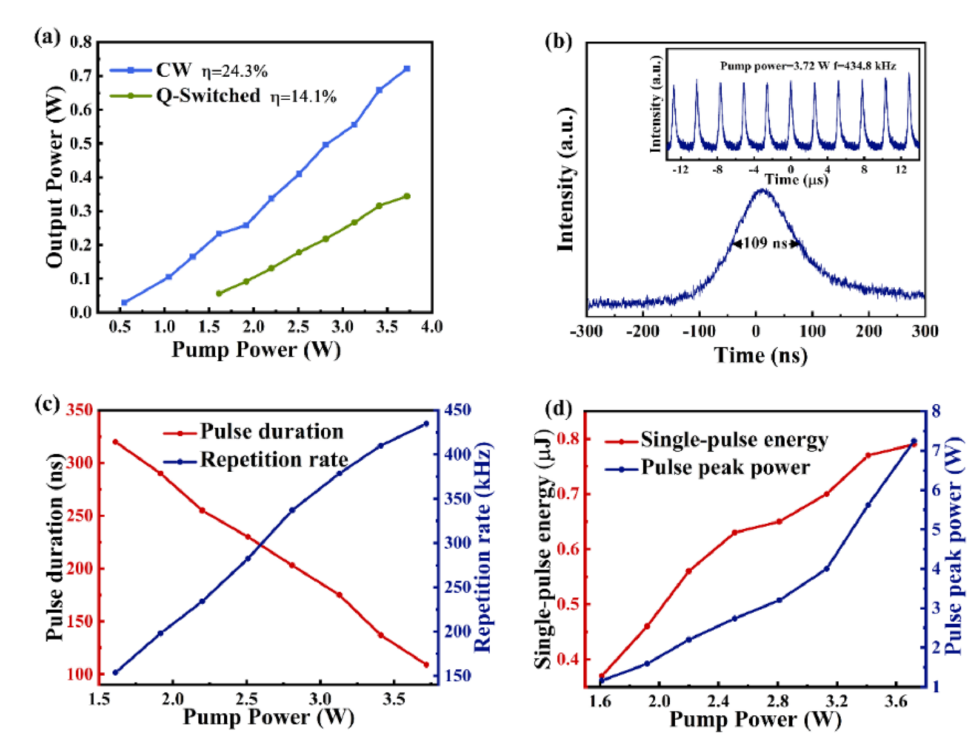
Figure 9. Q-Switched pulse output characteristics with the Ti 2 CT x -GO SA. ( a ) Average output power of continuous wave (CW) and Q-switched lasers under different pump powers; ( b ) single- pulse profile at a 3.72 W pump power with an output coupling (OC) mirror transmission of 15%; ( c ) evolution of the repetition rate and pulse duration with pump power; ( d ) single-pulse energy and peak power as a function of pump